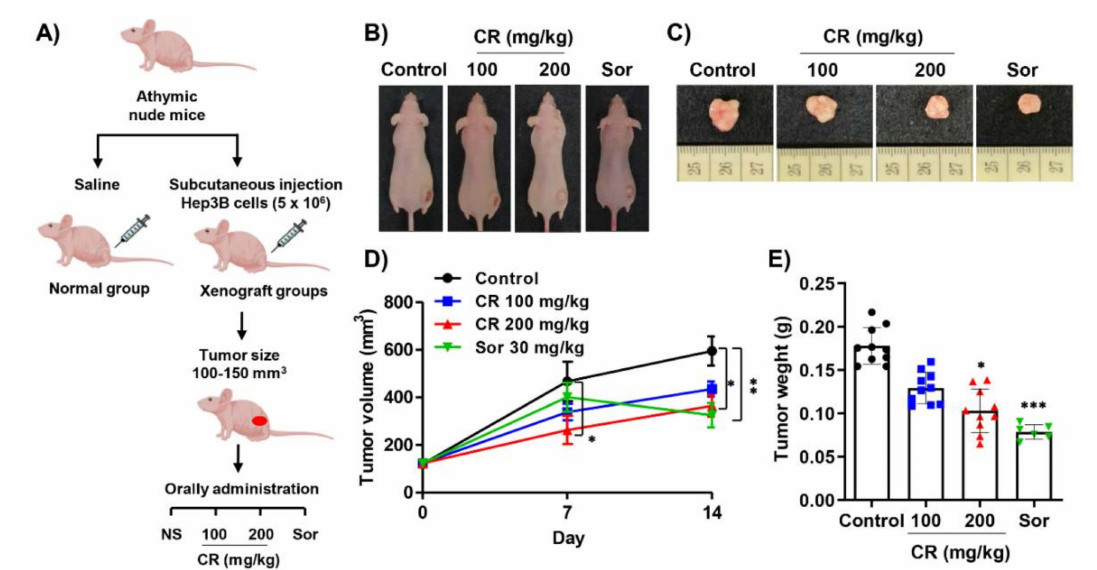
Figure 5. CR inhibits tumor growth in Hep3B xenograft model. ( A ) Experimental design of Hep3B xenograft model. The xenograft was induced in athymic nude mice by subcutaneous injected into the flank with 5 × 10 6 cells/100 µ L. Ten days after tumor injection, mice were randomly divided into four groups: Control (distilled water), low and high concentration of CR (100 and 200 mg/kg), and sorafenib (30 mg/kg). All treatments were orally administrated once per day for 14 days. ( B ) Image of the xenograft model showing the size of tumors treated with CR or sorafenib. ( C ) Representative images of the xenograft tumors. ( D ) Tumor volumes obtained from xenograft mice were measured once a week. Data presented as the mean ± SD ( n = 6~10). * p < 0.05 and ** p < 0.01 compared to the non-treated group. ( E ) Tumors isolated from each group of xenograft mice were measured. Data presented as the mean ± SD ( n = 6~10). * p < 0.05 and *** p < 0.001 compared to the non-treated group. (Sor;